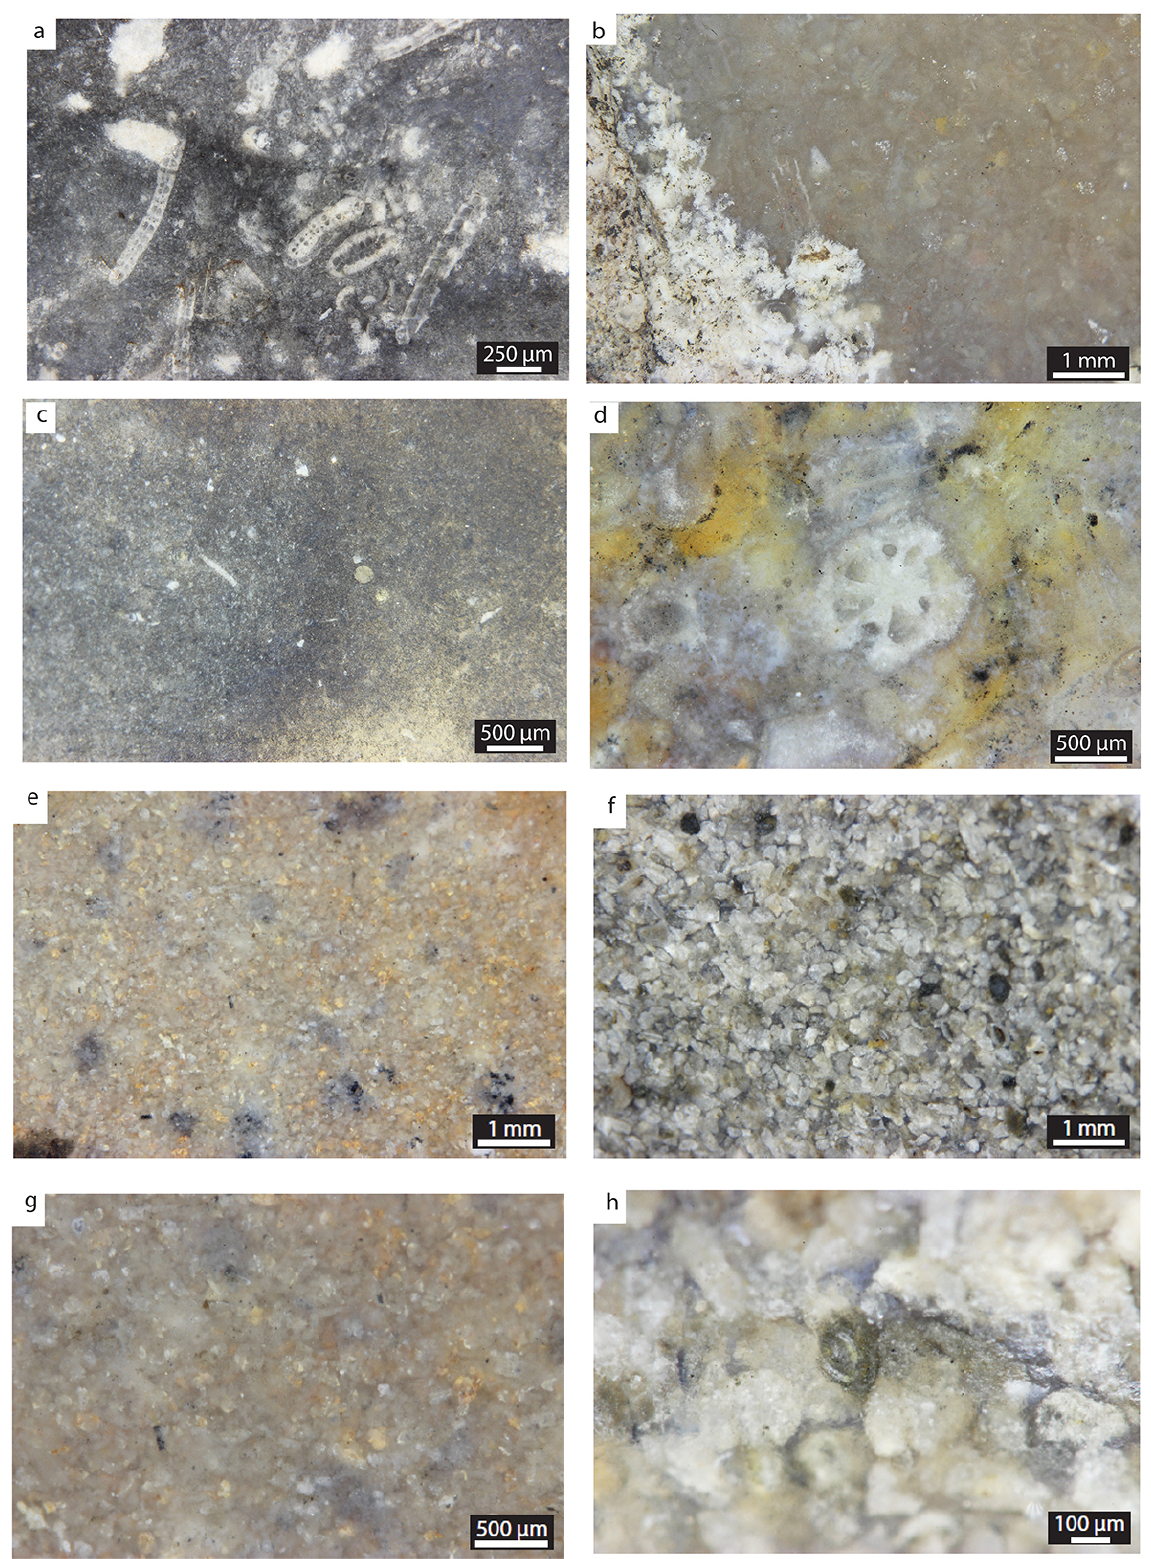
Figure 2. a: middle Santonian flint from Charentes with a Bryozoaire; b and d: Grain de mil Flint with Bryozoaires; c: Indeterminate Senonian flints with sponge spicule fragments; e and g: Grand Pressigny flint; f and h Coussay flint with Miliolidés. Photographs taken by S.